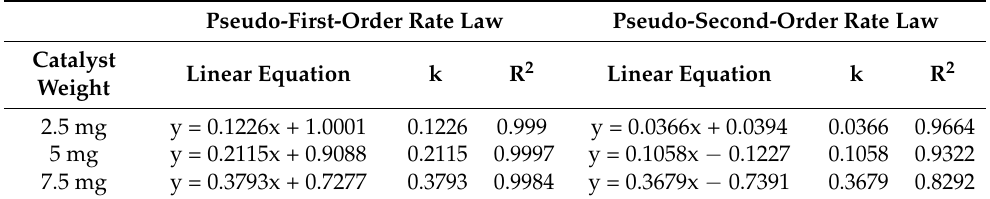
Table 1. CIP degradation kinetic model with the involvement of CuFe 2 O 4 /rGO/HNT.